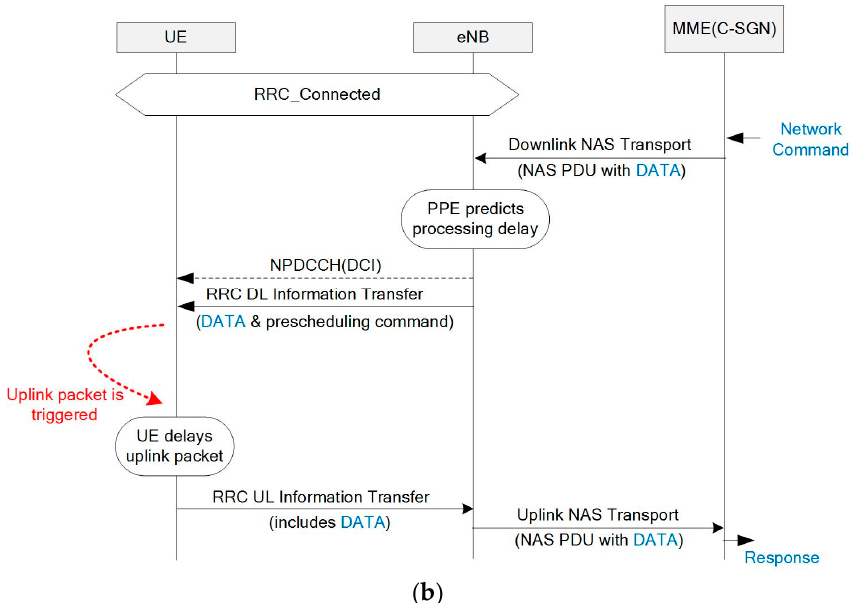
Figure 12. Network command and UE response scenario: ( a ) existing NB-IoT; ( b ) proposed PBESM.